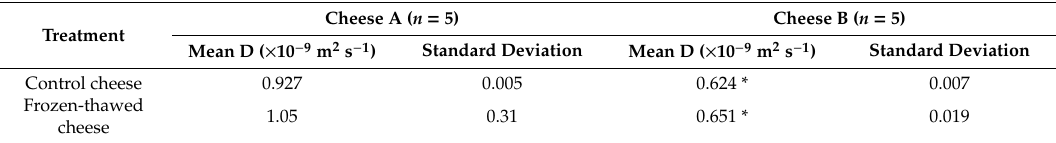
Table 2. Averaged 1 H self-di ff usion coe ffi cient (D) ( × 10 − 9 m 2 s − 1 ) of cream cheese formulations A and B before and after freezing and thawing.